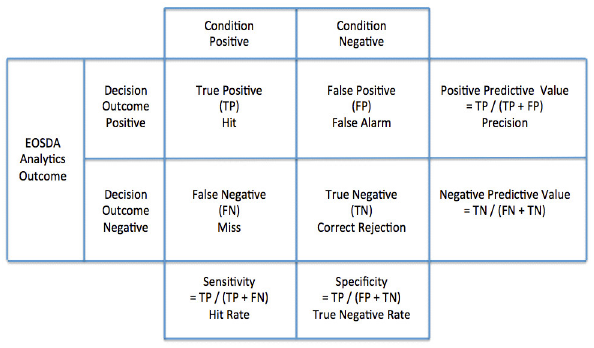
Figure 5. The matrix of classification errors for 1 class The overall evaluation of the accuracy of automatic classification is determined by the formula: